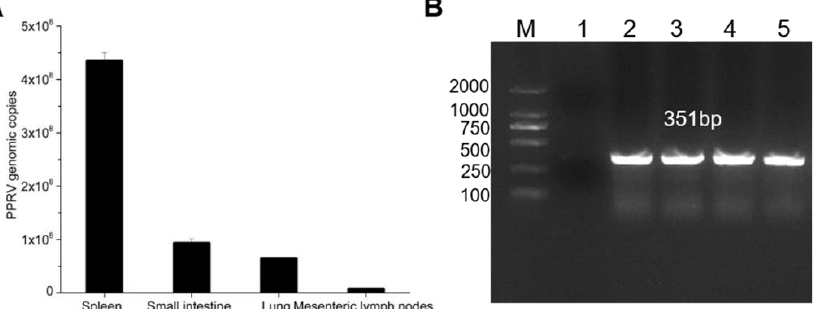
Figure 1. Identification of the PPRV. ( A ) PPRV infection was detected by qPCR. Genomic copies of PPRV per gram of tissues; ( B ) PPRV infection was detected by PCR with N fragment. M: DL2000. (1) Negative control; (2) lung; (3) spleen; (4) small intestine; (5) mesenteric lymph nodes.